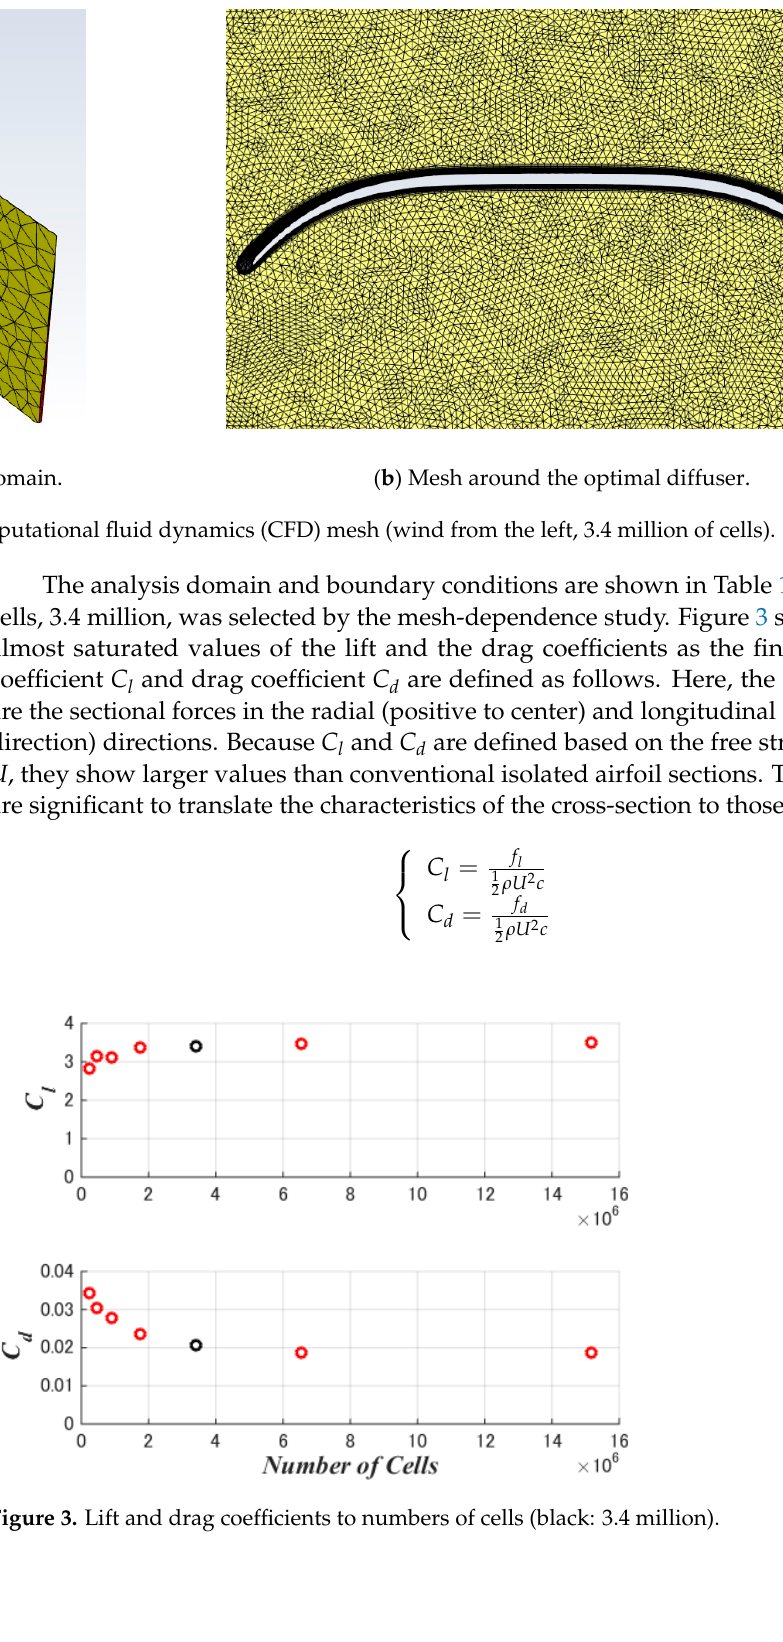
Figure 3. Lift and drag coefficients to numbers of cells (black: 3.4 million).